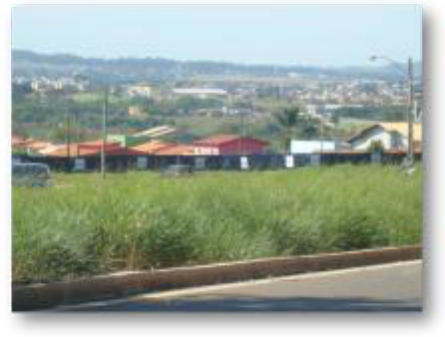
Figure 15. Spatial query: districts with amount of vegetation higher than 0.8 and income lower than R$ 1,244 (yellow).